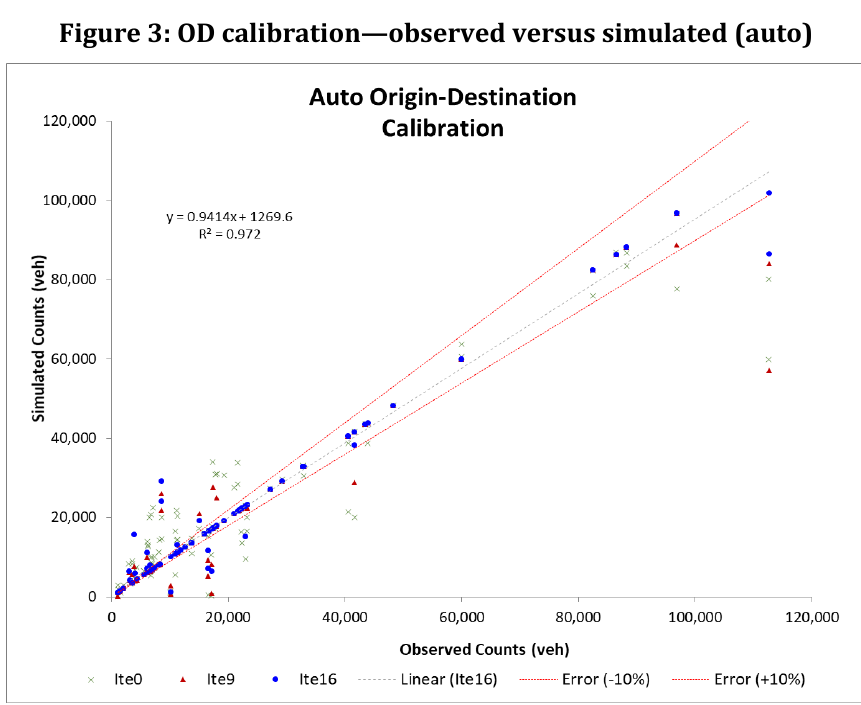
Figure 3: OD calibration—observed versus simulated